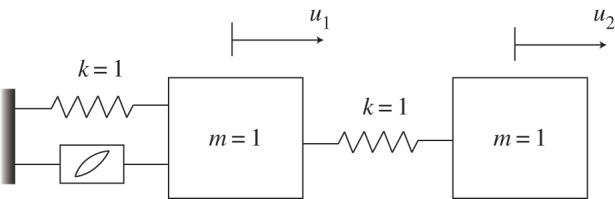
A two degree of freedom spring–mass system with a hysteretic damper.